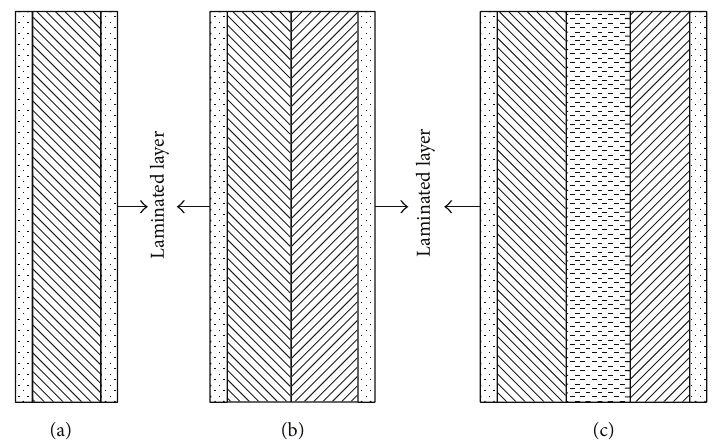
Figure 3: Structure type classification: (a) structure I, (b) structure II, and (c) structure III.